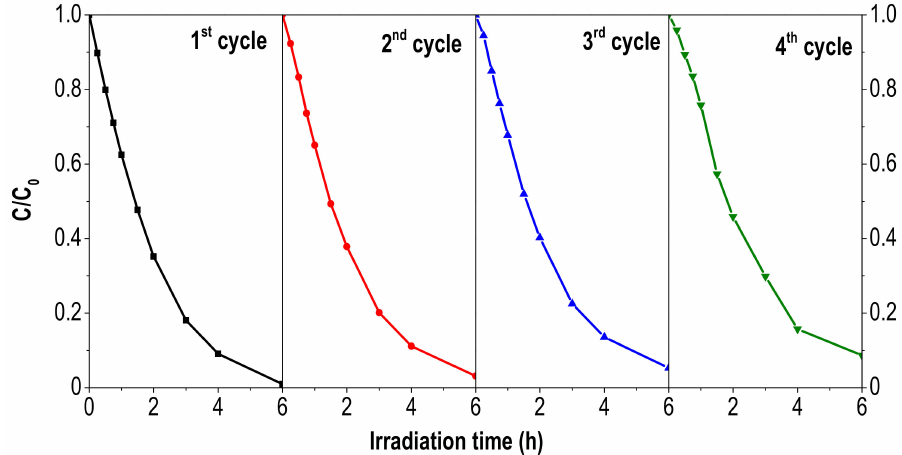
Figure 8. ACE removal with TiO 2 /Fe-C during consecutive cycles (Reaction conditions identical than those from Figure 6).